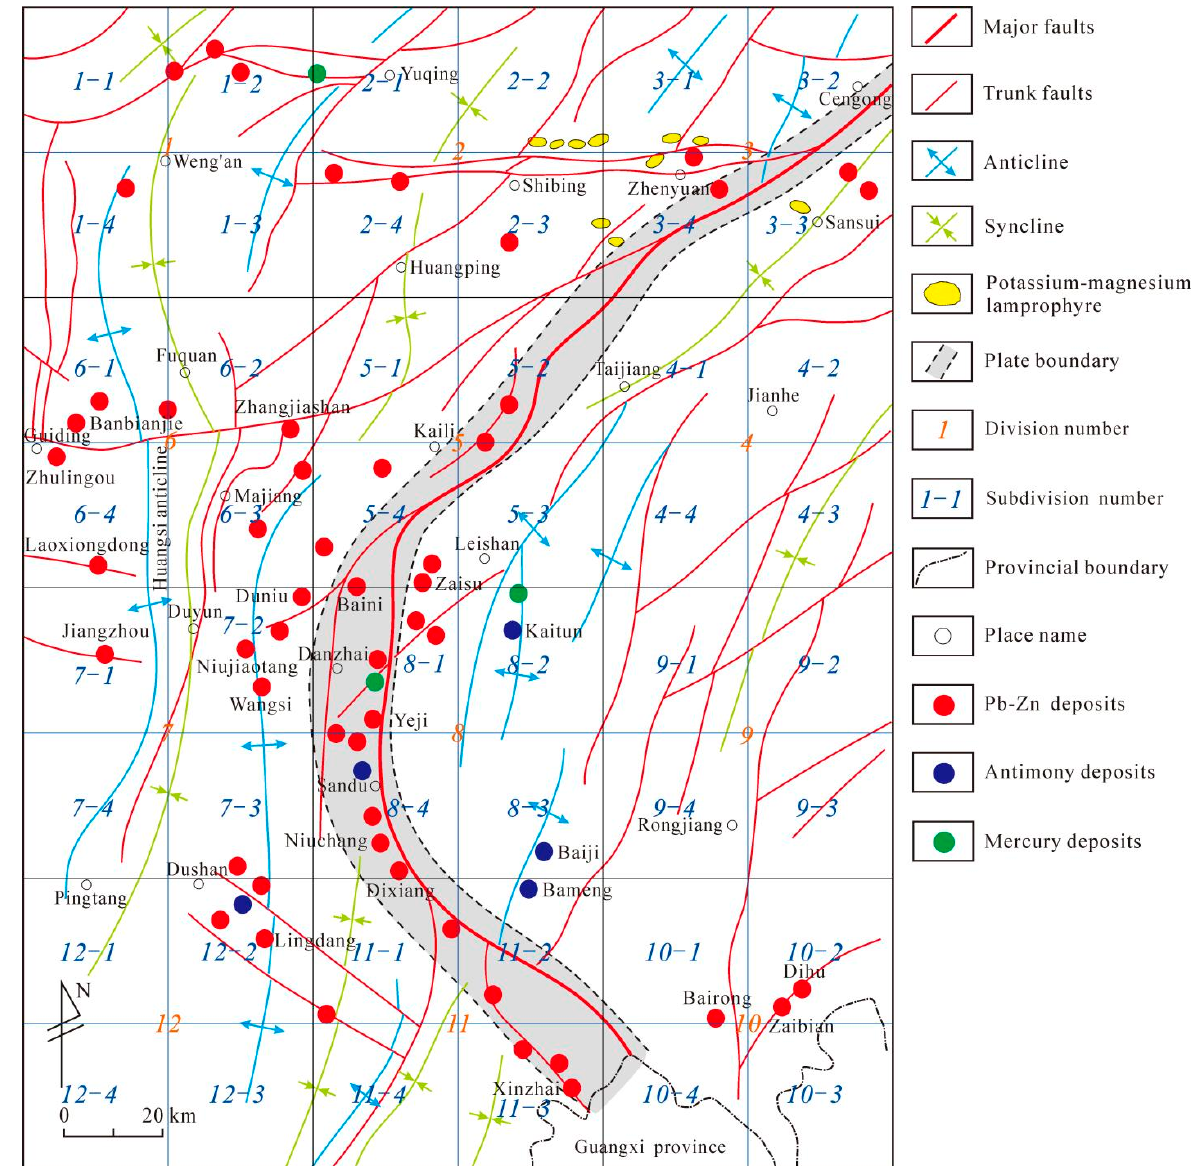
Figure 2. Computation partition map of fractal dimension (modified from Ref. [26]).